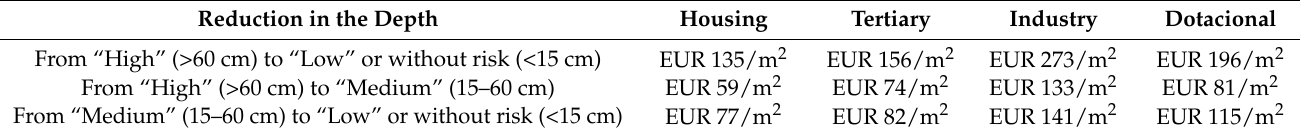
Table 2. Estimate of the benefits due to a reduction in the damage to property according to land use in Vega Baja, in euros per square metre. Own elaboration based on